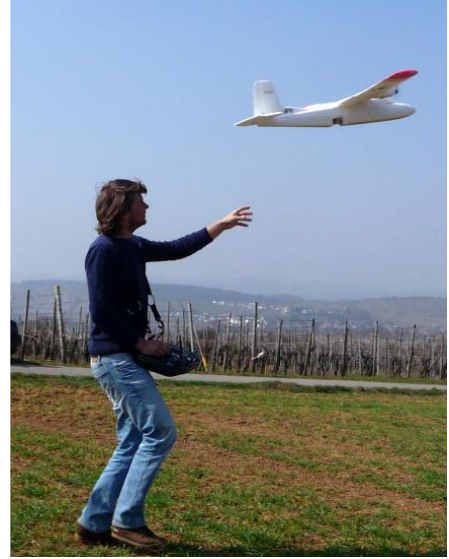
Figure 1: Used fixed-wing UAV platform in flight.